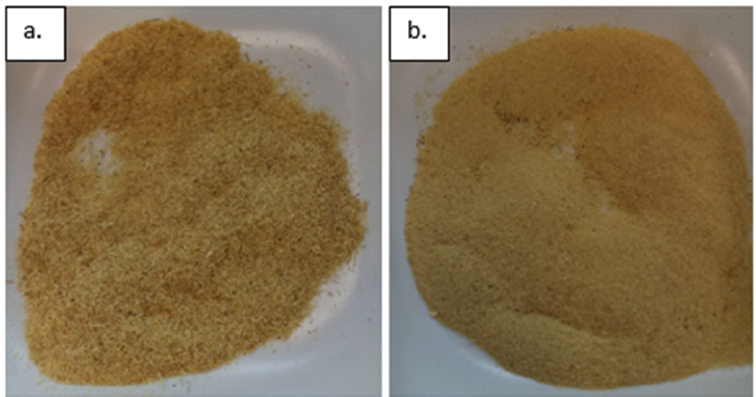
Figure 1. Sieved bagasse particles: ( a ) ≤ 300 µm and ( b ) ≤ 212 µm.